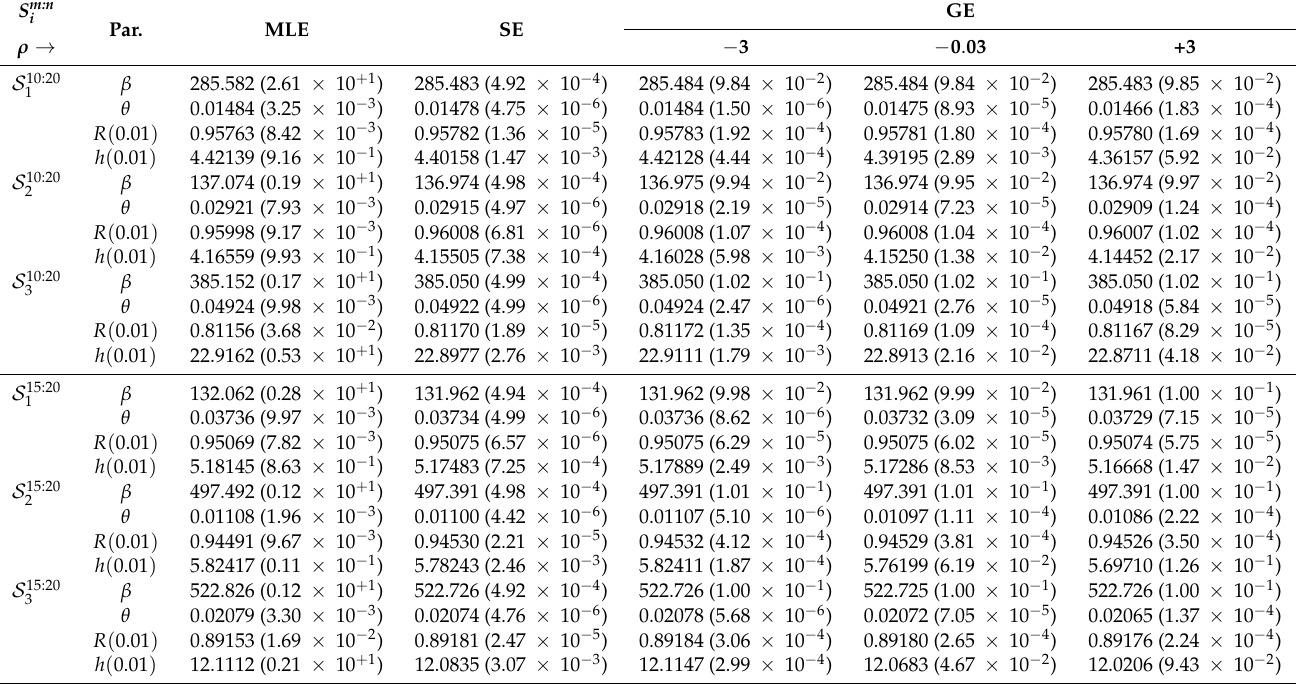
Table 6. The point estimates (St.Es) of β , θ , R ( t ) , and h ( t ) under SSB data.